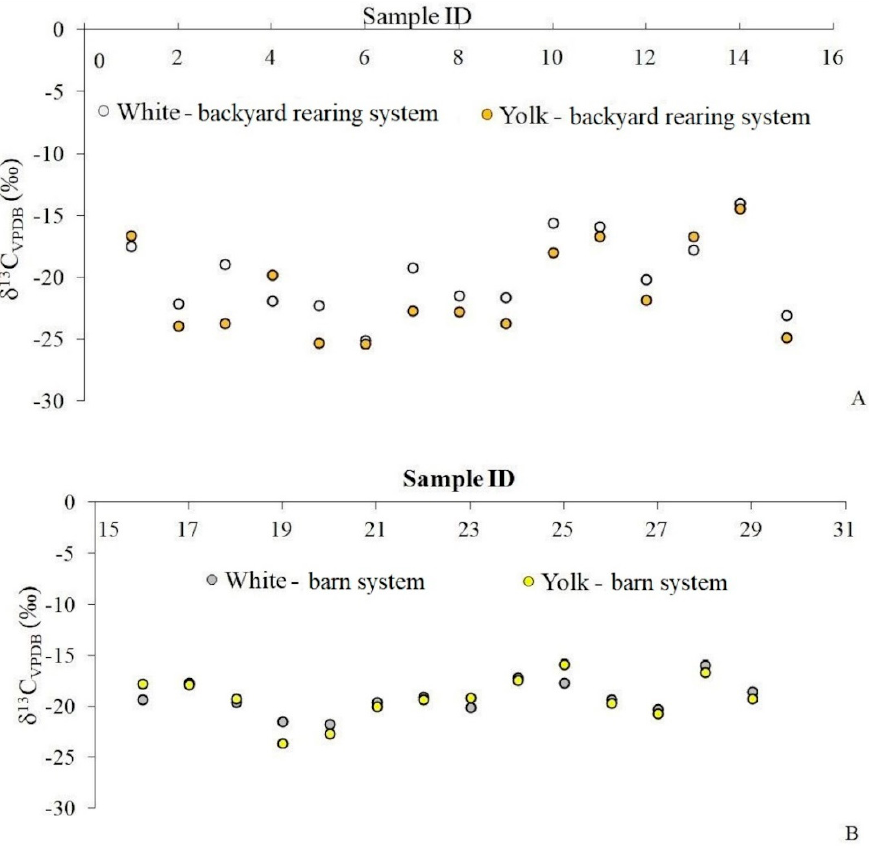
Figure 1. The δ 13 C values for investigated egg samples coming from: ( A ) backyard rearing system; ( B ) barn system.